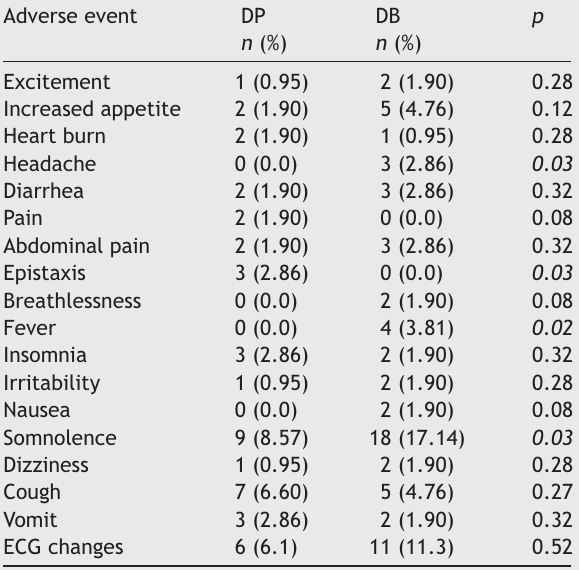
Global assessment of the participant regarding received treatment: DP (desloratadine + prednisolone) or DB (dexchlorpheniramine + betamethasone).